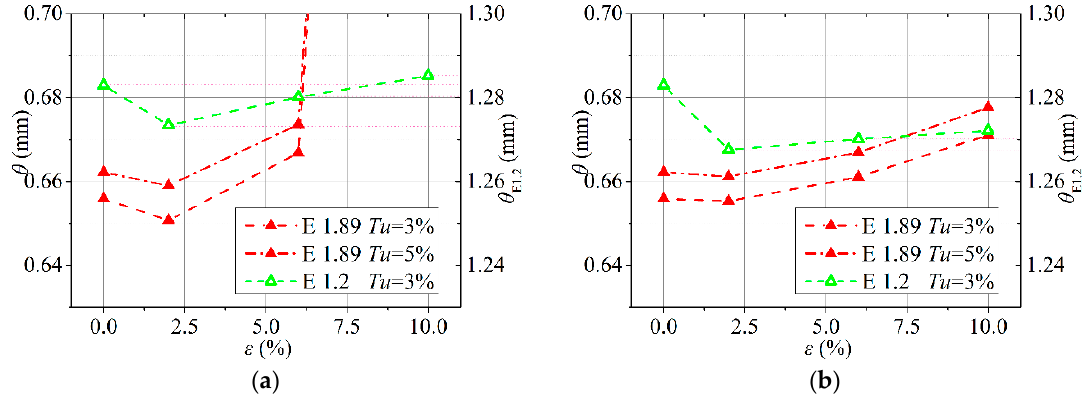
Figure 16. θ of different leading edges at the point of S = 50 in the middle turbulence condition: ( a ) BLUNT series; ( b ) WEDGE series.